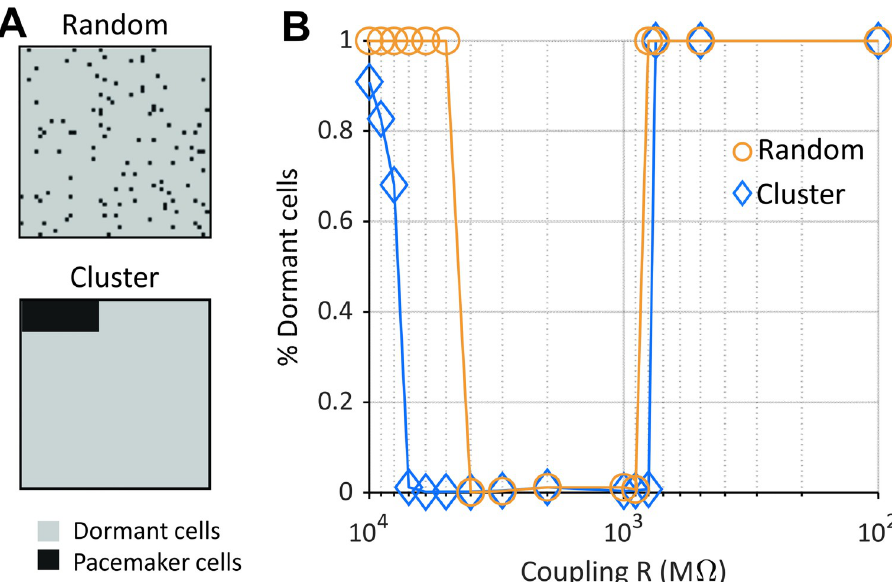
Fig 8. A small cluster of pacemaker cells can drive a prevalently dormant tissue. (A-top) (A) In the random tissue configuration dormant and pacemaker cells are interspersed in the matrix. (A-bottom) In the cluster configuration pacemaker cells are confined to a small portion of the matrix surrounded by dormant cells. Here dormant cells are cells that fail to depolarize after inhibition of I CaL by 50%. (B) The range of intercellular coupling compatible with AP generation and entrainment, i.e. reduced percentage of dormant cells, is wider in the cluster tissue configuration compared to the random. Results shown here were obtained with Fabbri human model ( σ equal to